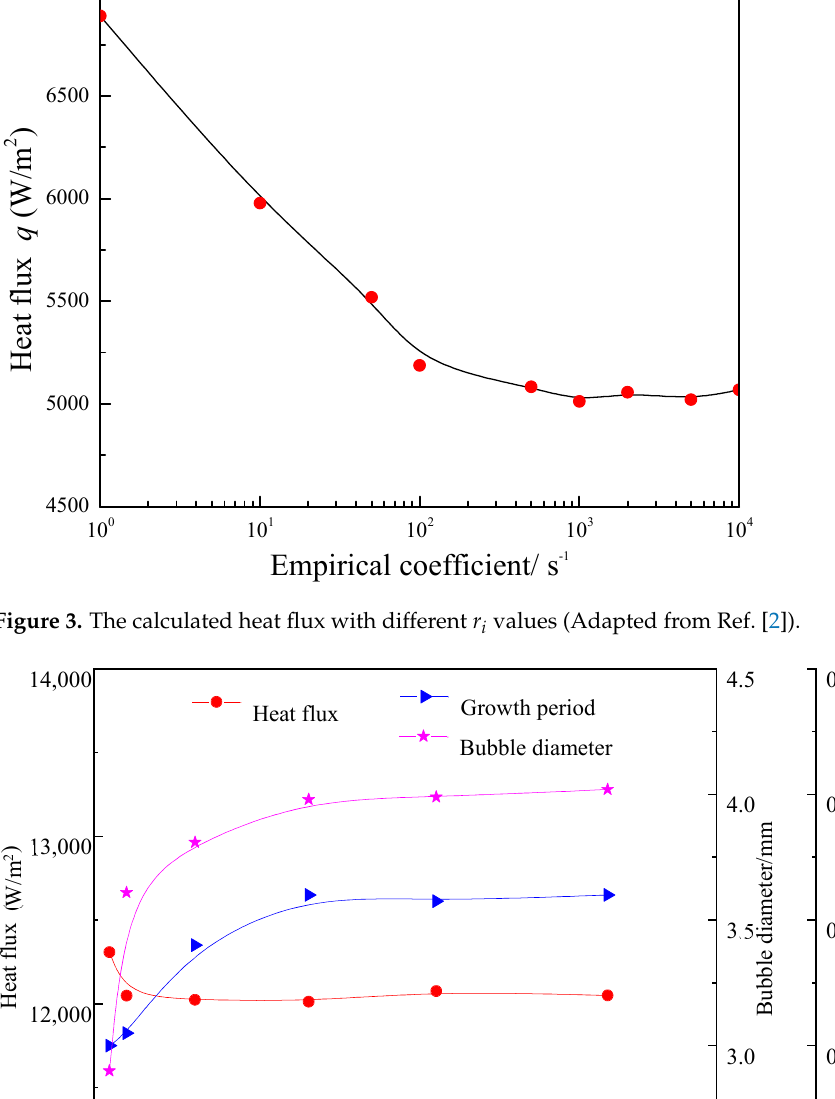
Figure 3. The calculated heat flux with different r i values (Adapted from Ref. [2]).